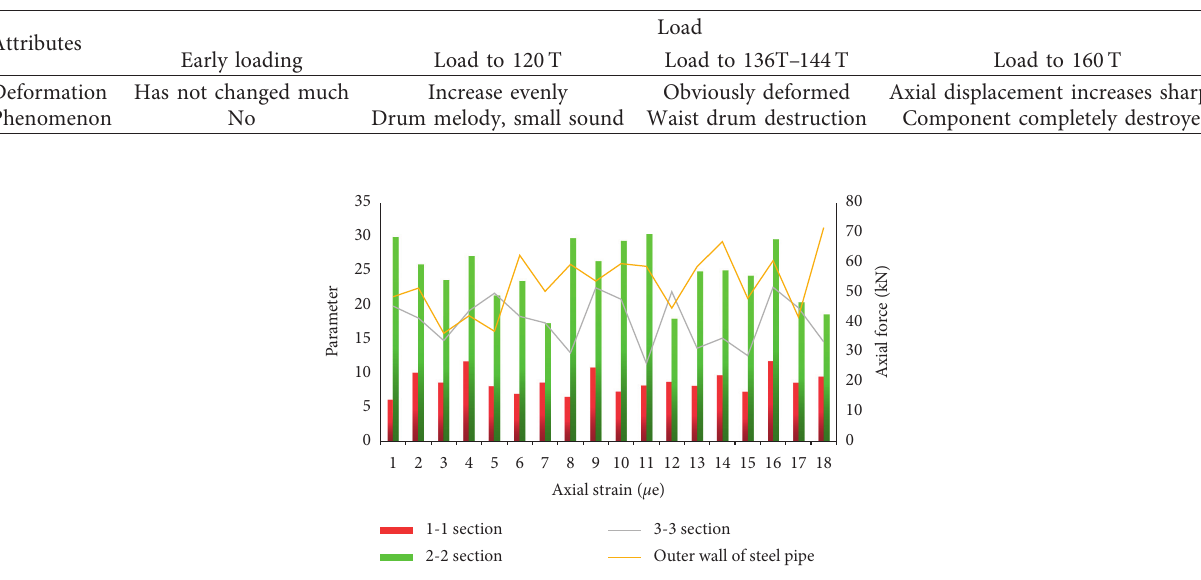
Table 4: Test phenomena at various stages.